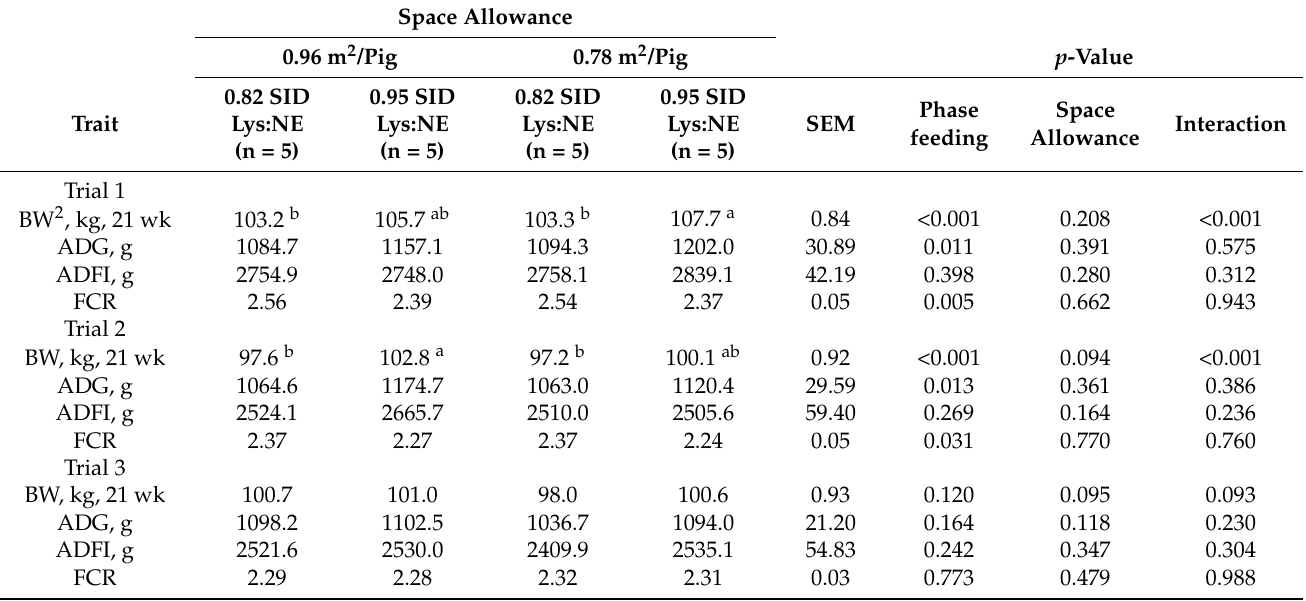
Table 4. Effect of space allowance and phase feeding on bodyweight (BW), average daily gain (ADG), average daily feed intake (ADFI) and feed conversion ratio (FCR) (Least square means (LS means) ± Standard error mean (SEM)) in trial 1 from 16 to 21 weeks of age, and in trial 2 and trial 3 from 15 to 21 weeks of age 1